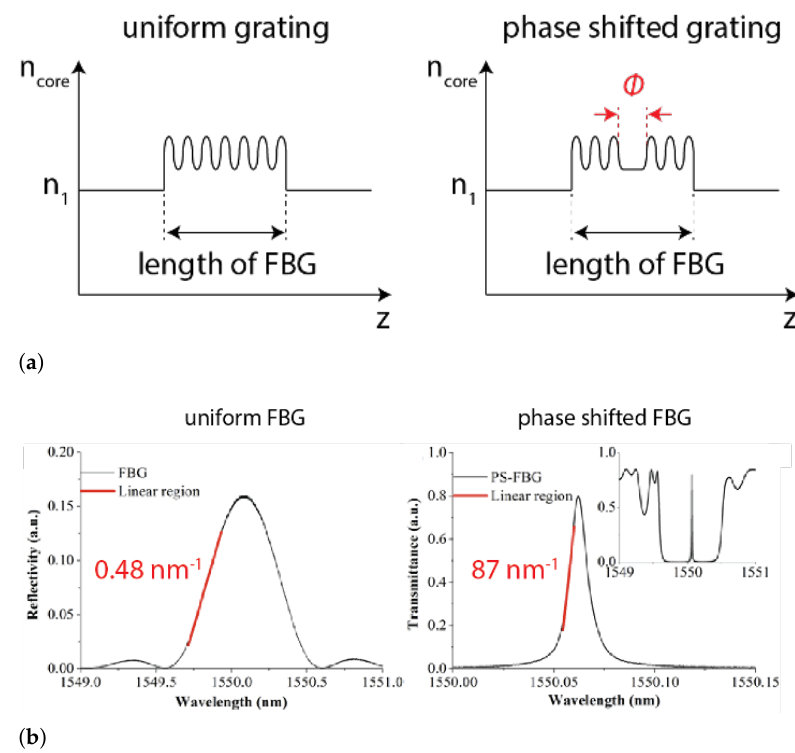
Figure 13. ( a ) Refractive index change of uniform and phase-shifted gratings and ( b ) the edge slope of the reflection spectrums for uniform and phase-shifted grating. Reprinted with permission from [68] ©The Optical